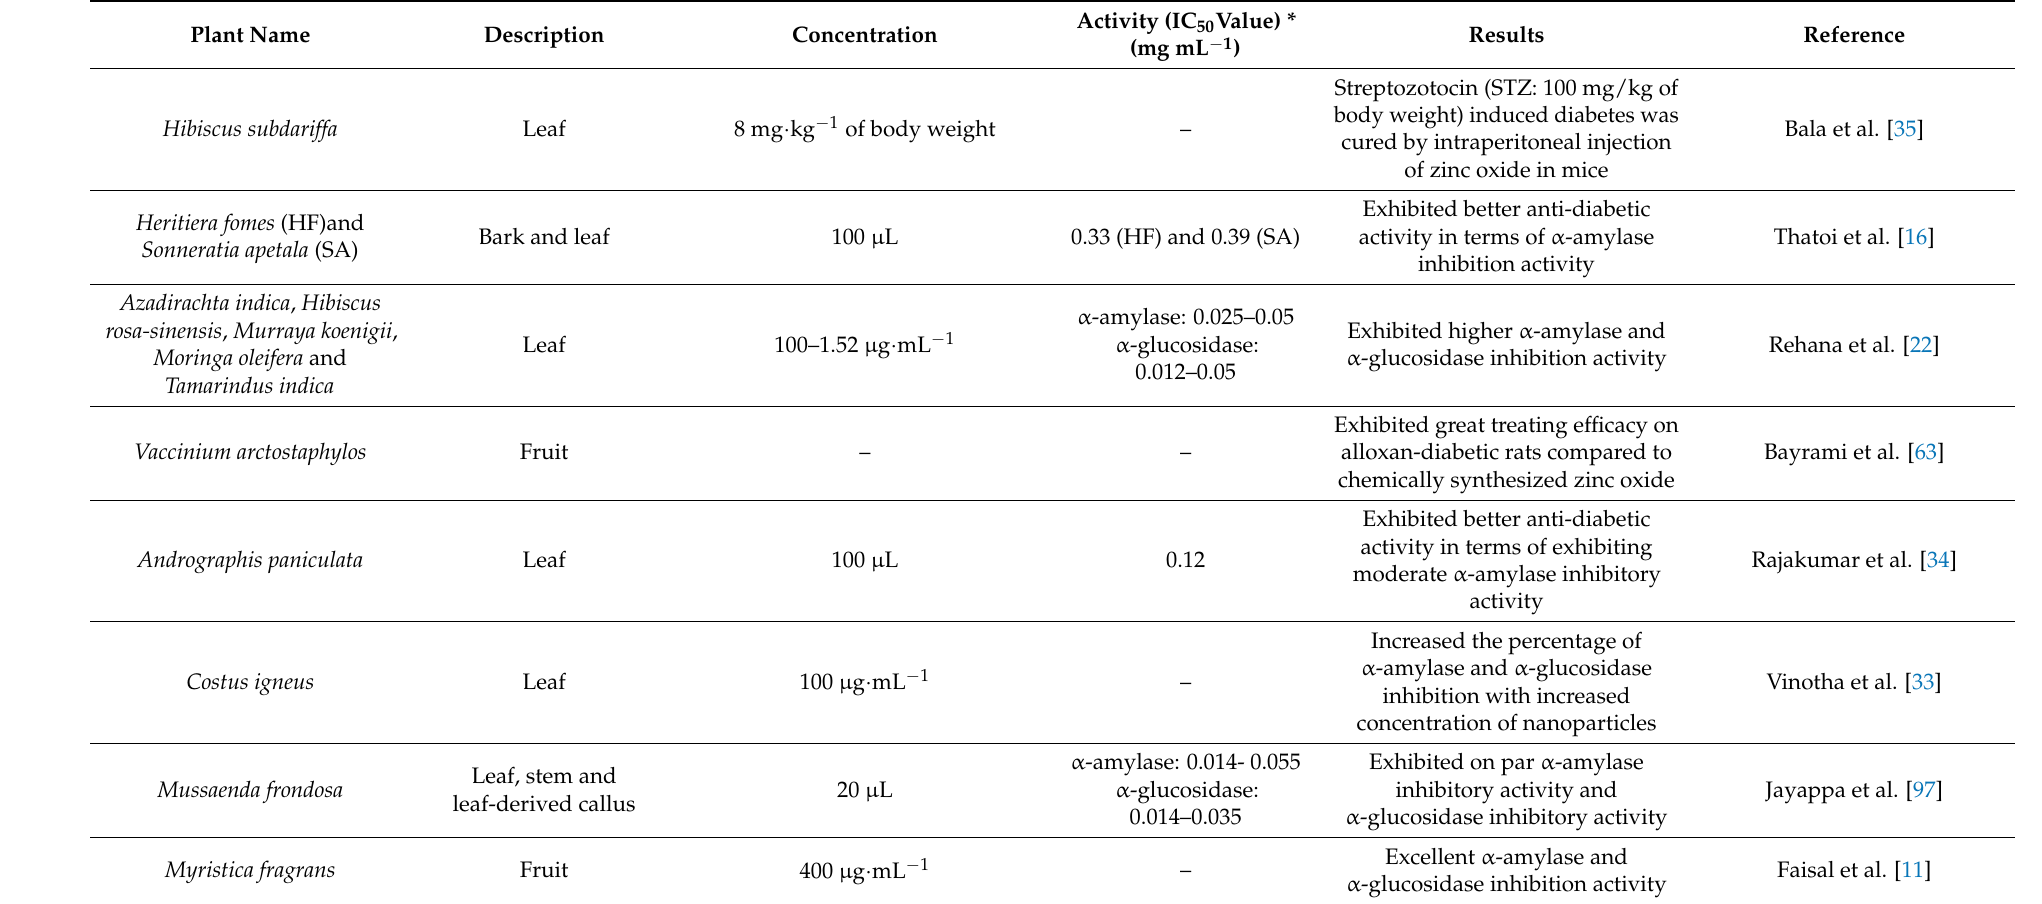
Table 4. Antidiabetic activity of plant-mediated zinc oxide